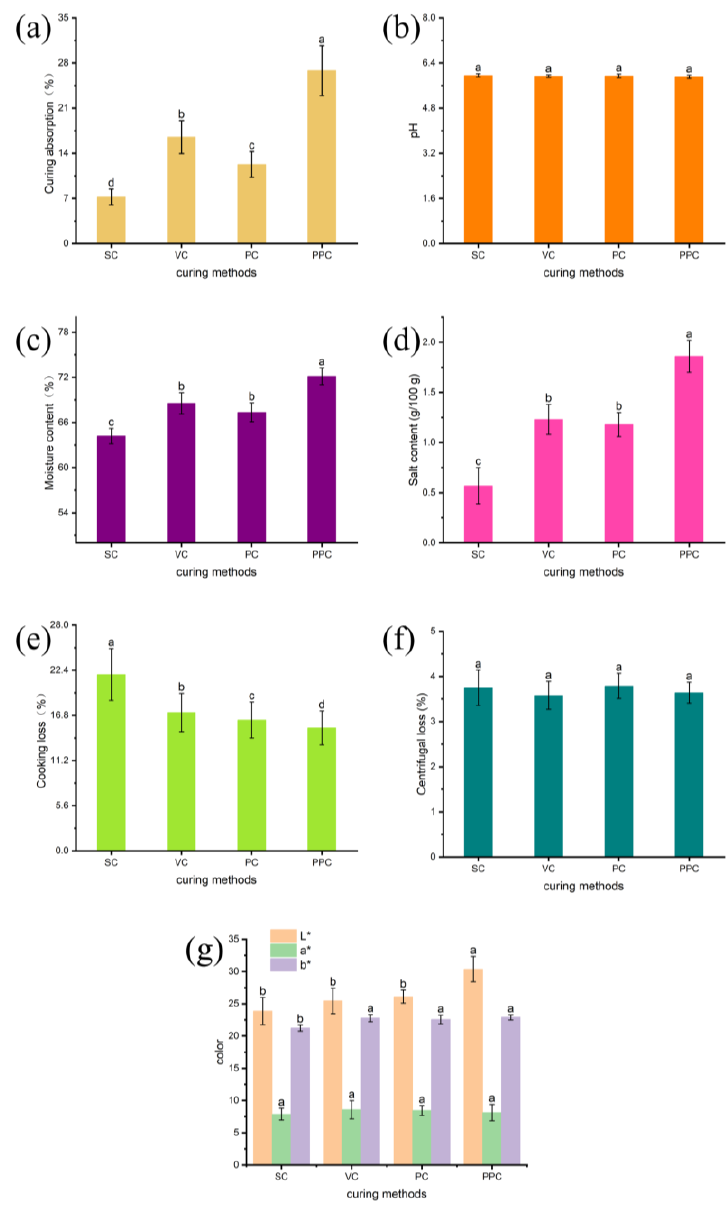
Figure 2. Effects of various curing techniques on the absorption of curing solution ( a ), pH ( b ), mois- ture content ( c ), salt content ( d ), cooking loss ( e ), centrifugal loss ( f ), and color ( g ) of beef. Different letters (a–d) in the same histogram indicate significant differences ( p <